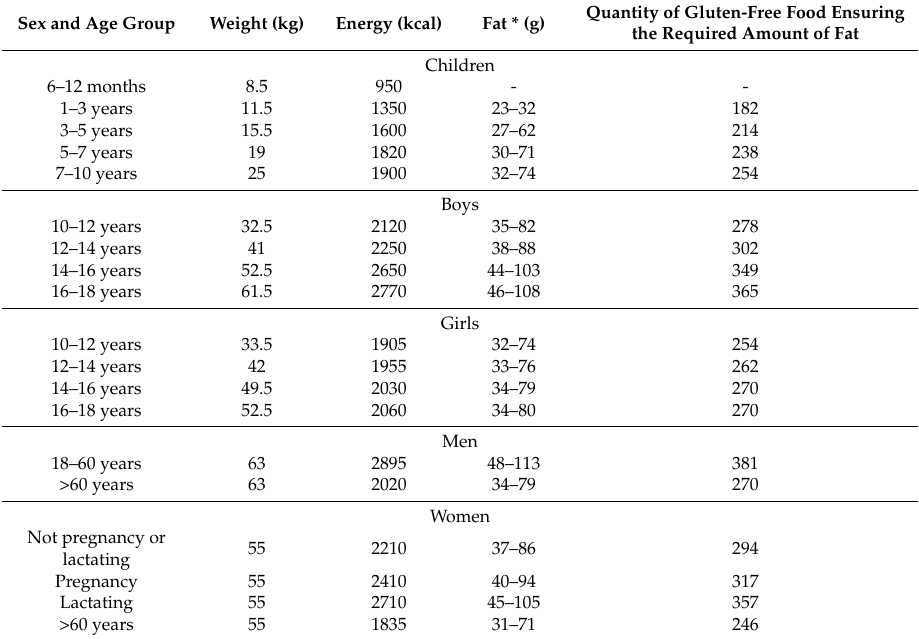
Table 3. Average individual energy requirements and safe levels of fat